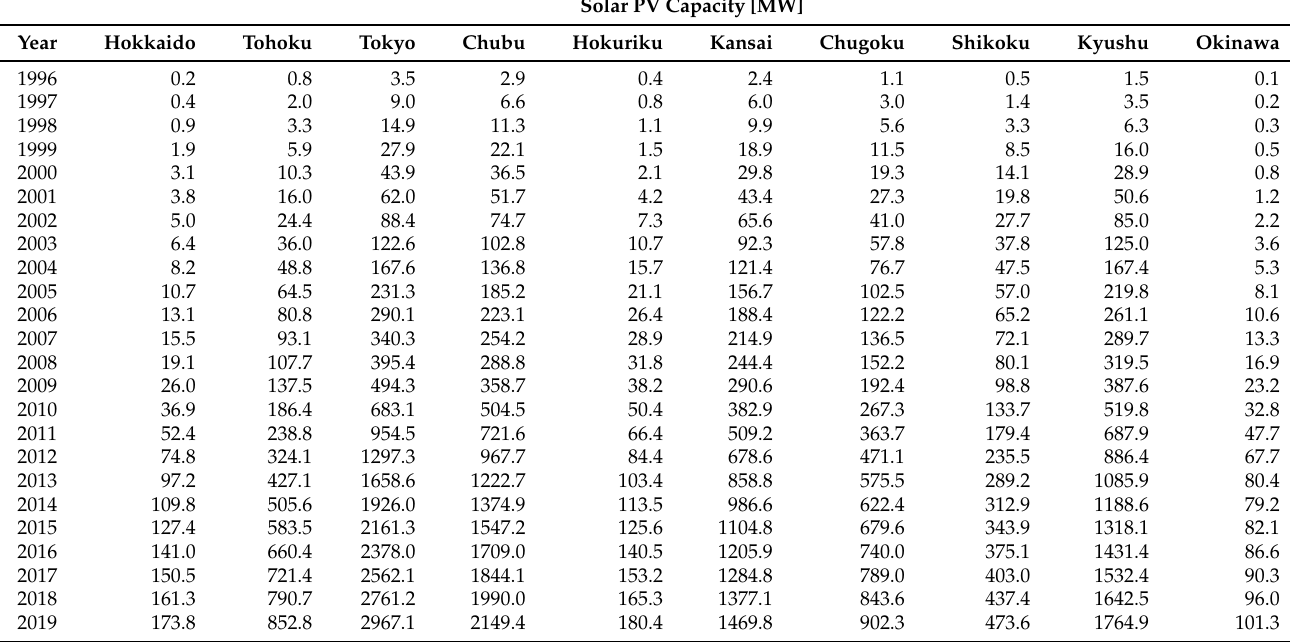
Table A3. Cumulative Residential Solar PV Capacity